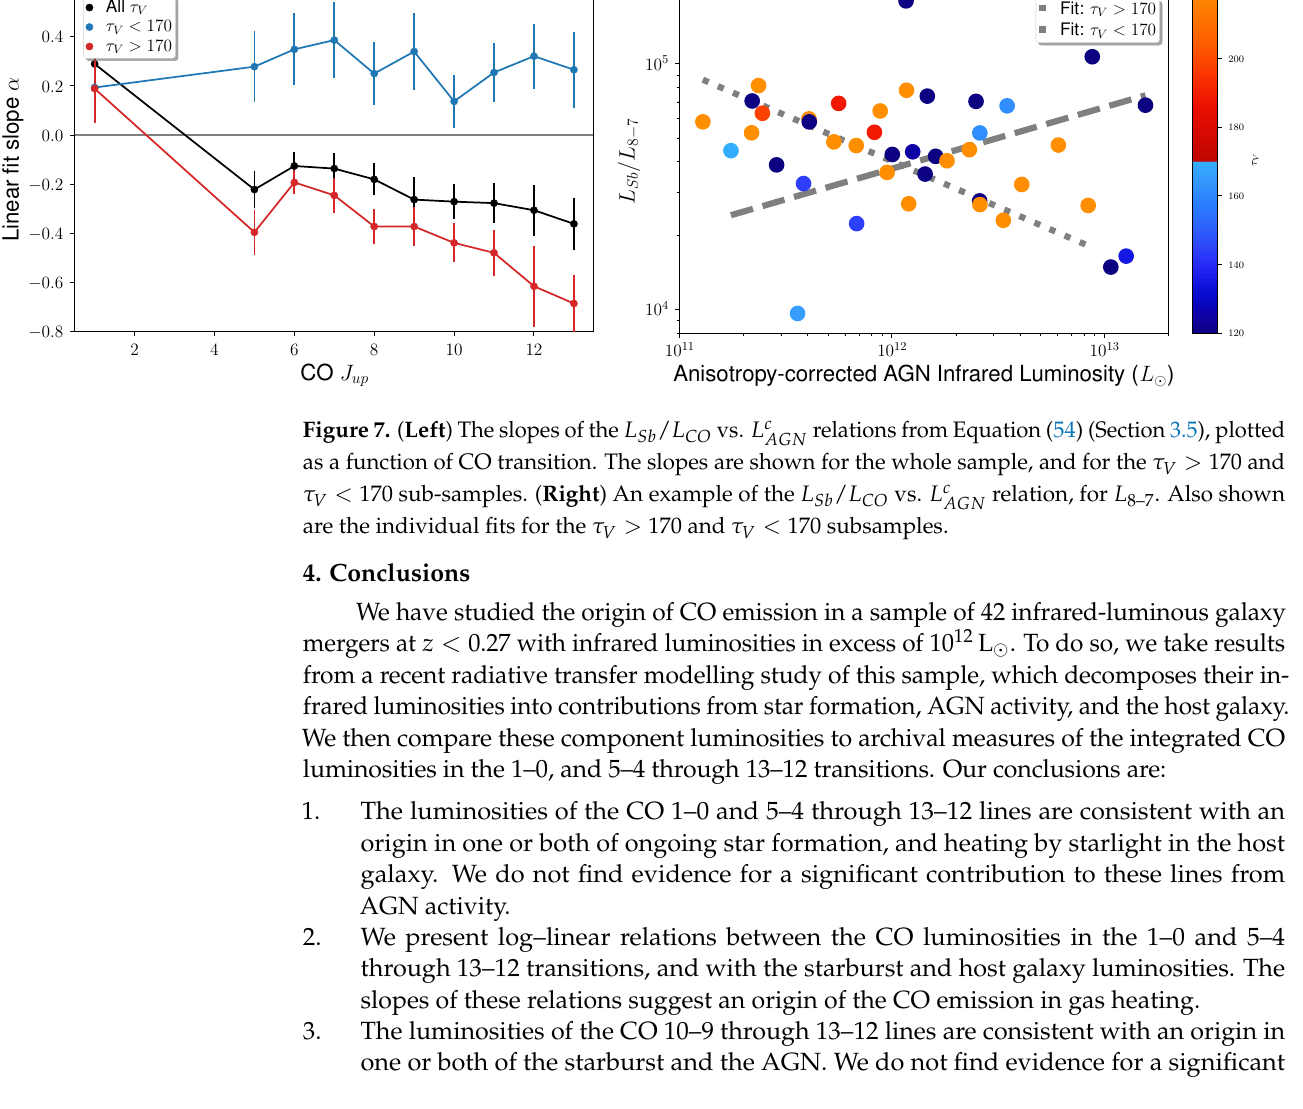
relations from Equation (54) (Section 3.5), plotted AGN relation, for L 8–7 . Also shown AGN